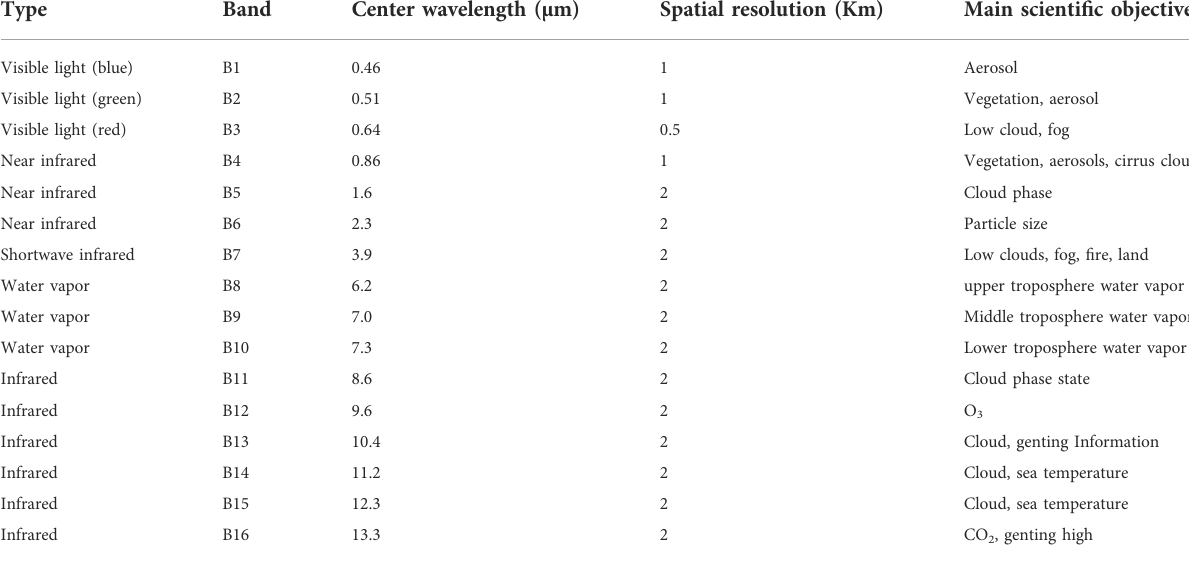
TABLE 1 Details of 16 bands information of the Advanced Himawari Imager (AHI) instrument on Himawari-8